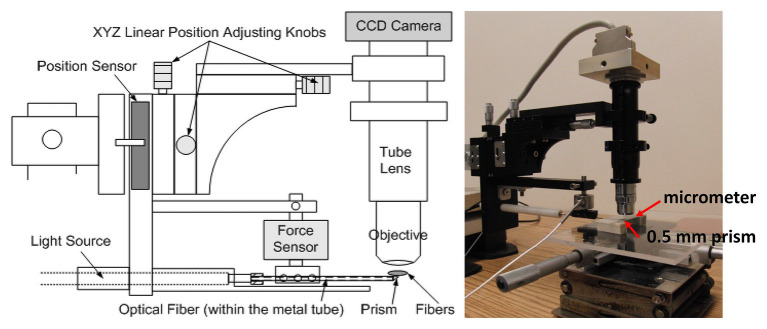
A schematic of the force microscope. Before testing, the stage micrometer was placed right above the prism to capture calibration images. During testing, the metal tube containing the prism was placed at the midpoint and underneath the muscle fibers. Starting from the initial position (i.e., no increase in the force on the tube due to muscle stretching), the tube was lifted up vertically step by step until the muscle fibers were stretched to 150% of the initial length.